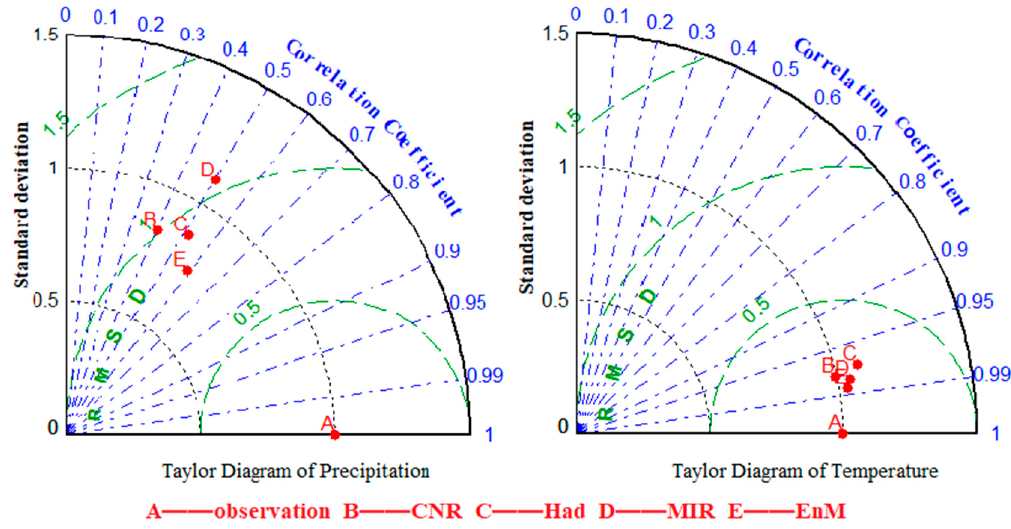
Figure 2. Accuracy test of three single CMIP5 model and EnM.